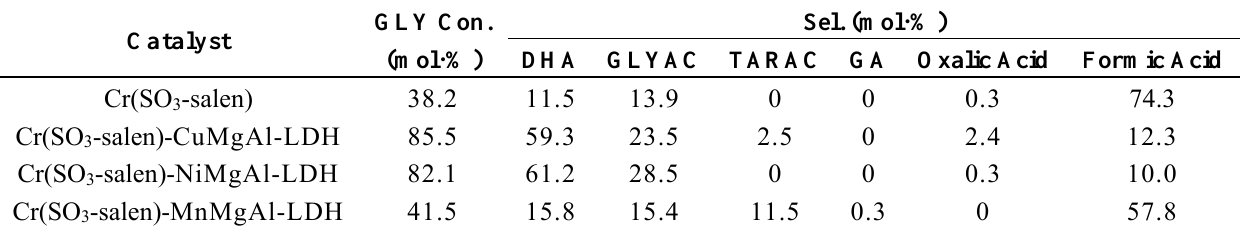
Table 3. Catalytic performance of complex samples in GLY oxidation a . Sel. (mol·%) GLY Con. Catalyst (mol·%) DHA GLYAC TARAC GA Oxalic Acid Formic Acid Cr(SO 3 -salen)